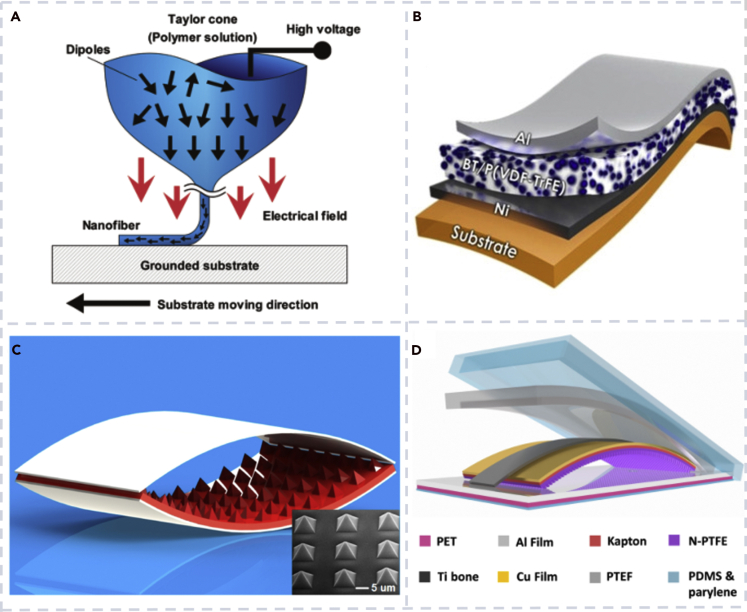
Biocompatible nanogenerator based on different polymers(A) Fabrication of piezoelectric PVDF nanofibers for a PENG by combing near-field electrospinning, direct-write, mechanical stretching, and in situ electrical poling (Chang et al., 2010).(B) Schematic of a PENG based on BT/P(VDF-TrFE) composites (Siddiqui et al., 2015).(C) Schematic illustration of a flexible arch-shaped TENG (Tang et al., 2015).(D) Schematic diagram of a biocompatible TENG based on nanostructured PTFE (Zheng et al., 2016a).